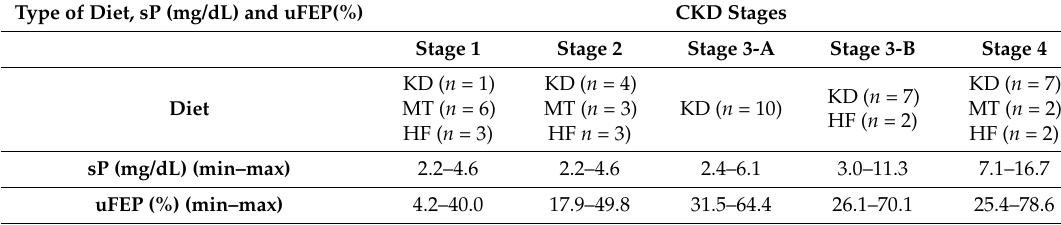
Table 1. Type of diet (commercial kidney diet—KD, maintenance diet—MT, homemade food—HF), urinary fractional excretion of phosphorus (%; min–max) and serum phosphorus concentrations (sP: mg/dL; min–max) among CKD dogs within different stages (stage 1 to stage 4). Type of Diet, sP (mg/dL) and